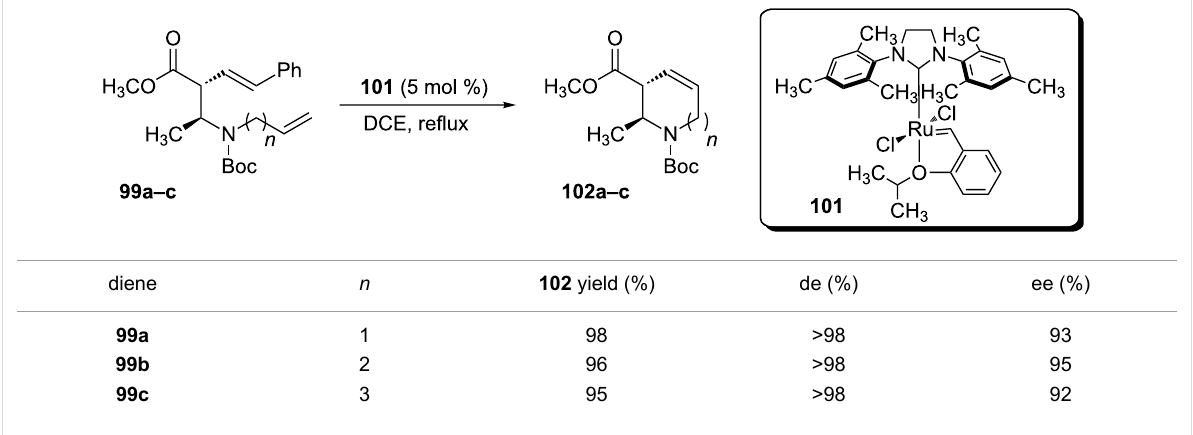
Table 11: Syntheses of N -heterocycles by RCM reported by Pavlyuk and